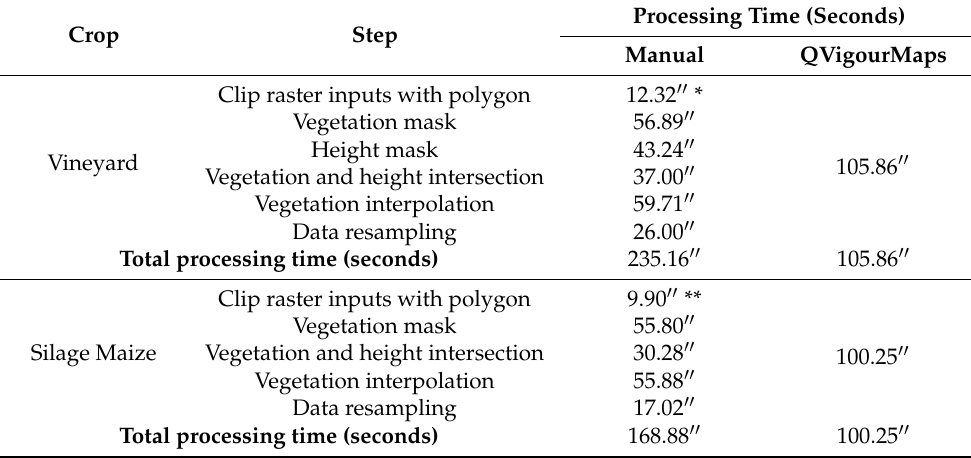
Table 2. Comparison of the performance of QVigourMaps through the processing times with the manual